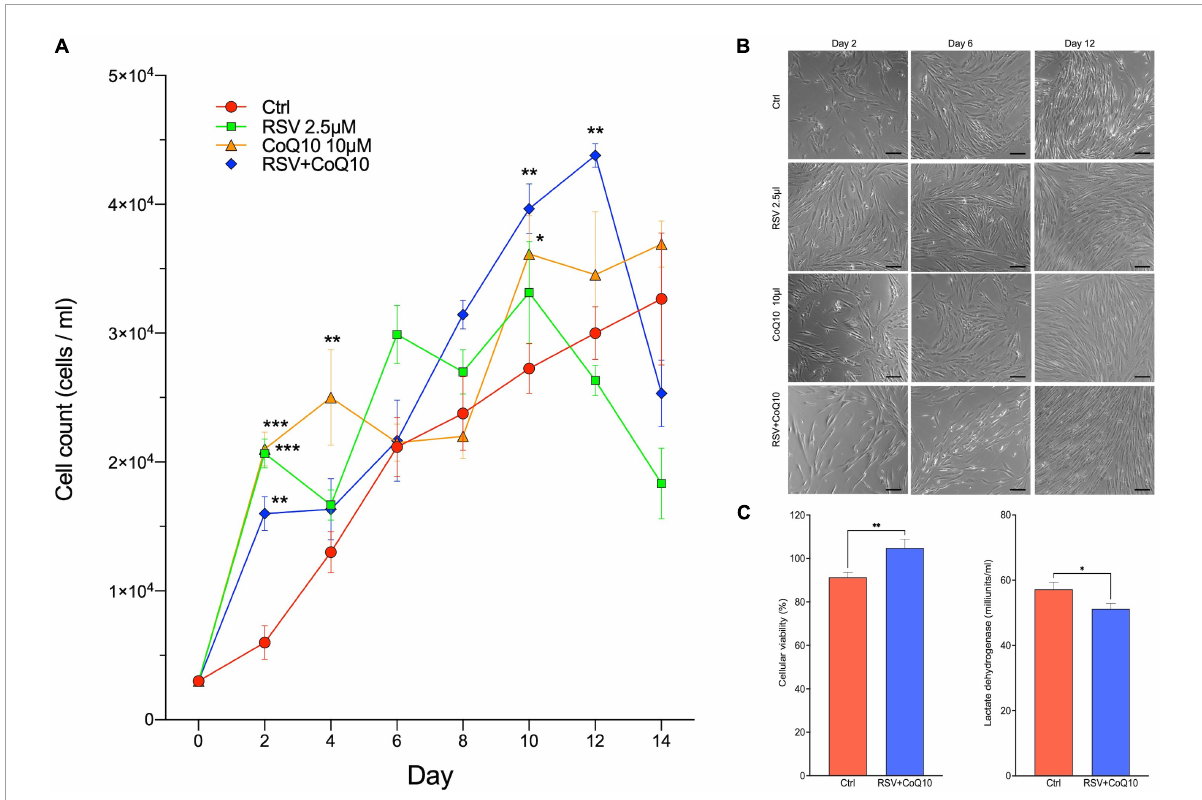
FIGURE3 Effects of RSV + CoQ10 supplementation to human mesenchymal stem cells (hMSCs) on kinetic growth, cellular viability, and lactate dehydrogenase (LDH). (A) Applying RSV(2.5 µ M), CoQ10 (10 µ M), or combination to hMSCs increased the number of cells on day 2 vs. control. The RSV + CoQ10 combination significantly enhances the number of cells on days 10 and 12. (B) Representative pictures of confluency of hMSCs under phase-contrast microscopy on three different days of kinetics. (C) On day 12, the application of RSV + CoQ10 increased cell viability. They reduced LDH levels compared to compare vs. control group. CoQ10, coenzyme Q10; RSV, resveratrol. * P < 0.05; ** P < 0.01; *** P < 0.001. One-way ANOVA was followed by Dunnett’s test for kinetic growth curve and t -test for cell viability and LDH levels. Scale bar: 25 µ